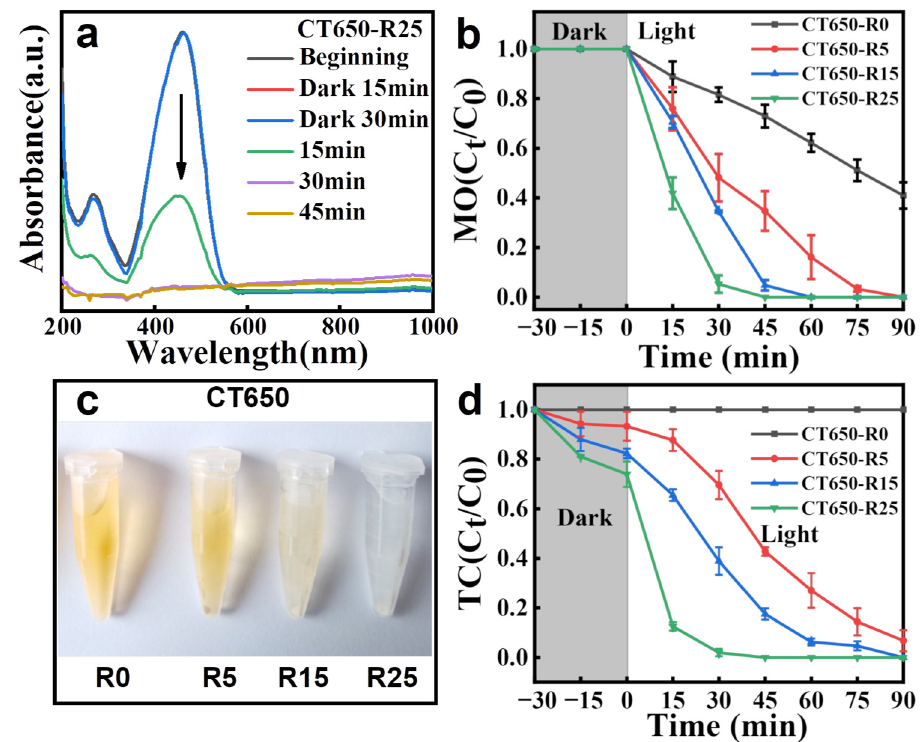
Figure 4. The photocatalytic activity of TiO 2 regulated by OA. ( a ) The absorption spectra of MO degraded by CT650-R25. ( b ) The varied degradation rate of MO under light irradiation, ( c ) graph of the supernatants reacted for 30 min and ( d ) the evolution of the degradation rate of TC by using catalysts CT650-R25, CT650-R15, CT650-R5 and CT650-R0.